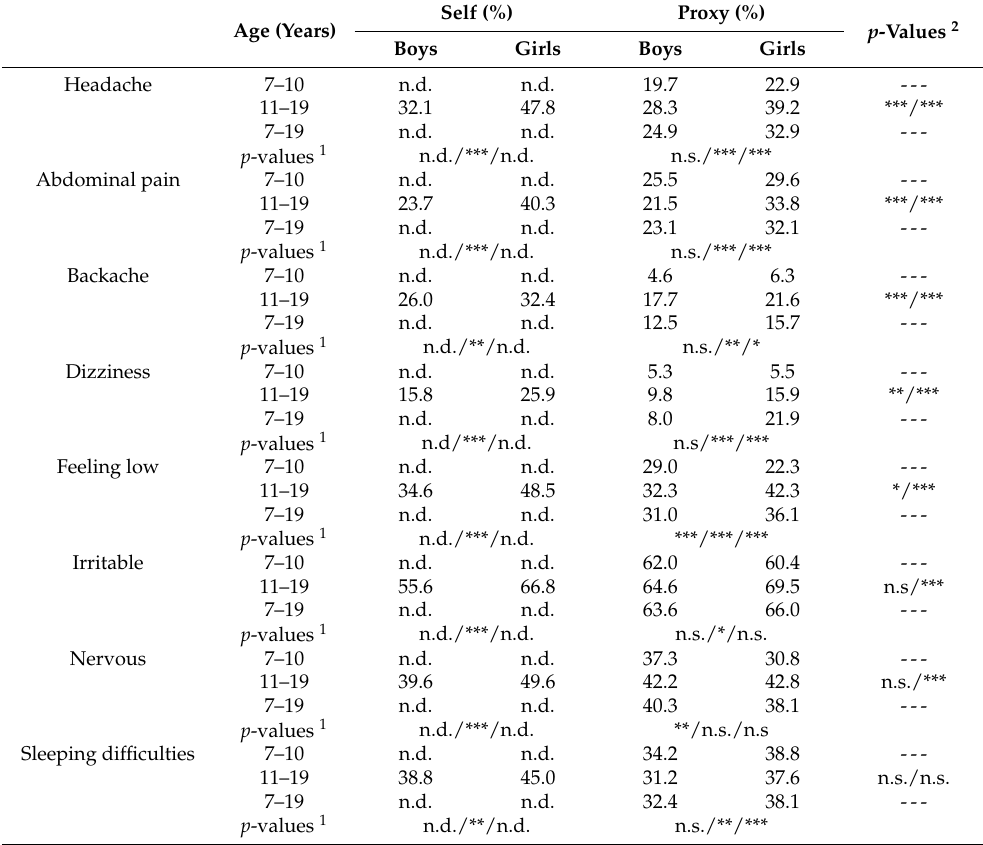
Table 4. Subjective health complaints of children and adolescents experienced weekly or more often, according to scholars’ age, gender, and self or proxy